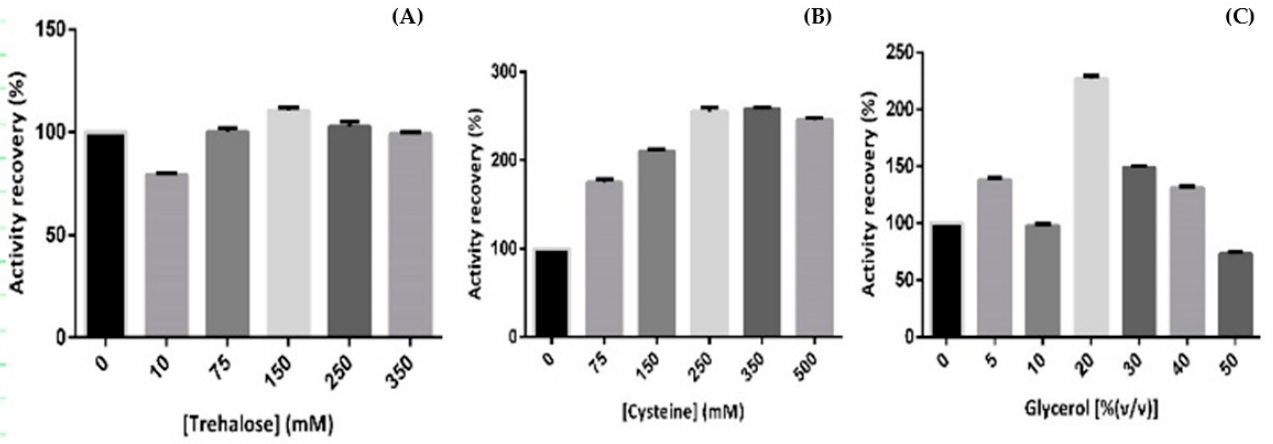
Figure 1. Percentage of hSCOMT activity recovery in the presence and absence of ( A ) trehalose (0 to 350 mM); ( B ) cysteine (0 to 500 mM); ( C ) glycerol (0 to 50%) during a 12 h period. Each value represents the mean of 3 independent samples.